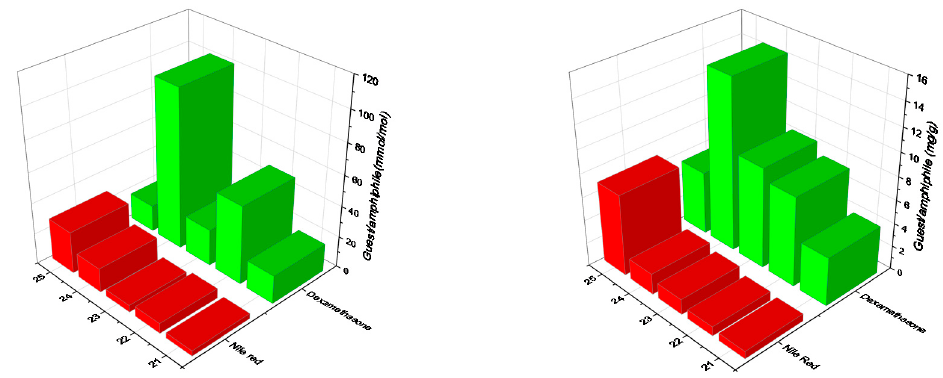
Figure 4. Emission spectra of Nile red encapsulated in the amphiphiles 21–25 in aqueous media and absorption spectra of Nile red encapsulated in the amphiphile solutions 21–25 in methanol.